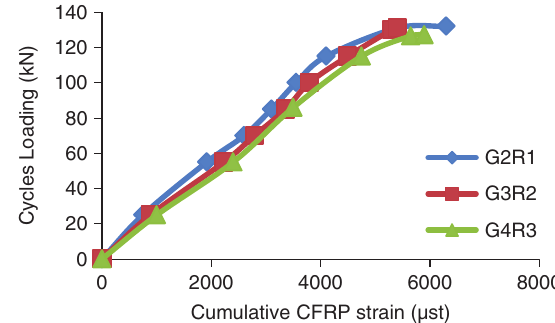
Fig. 8. Load against the cumulative CFRP strain of the tested